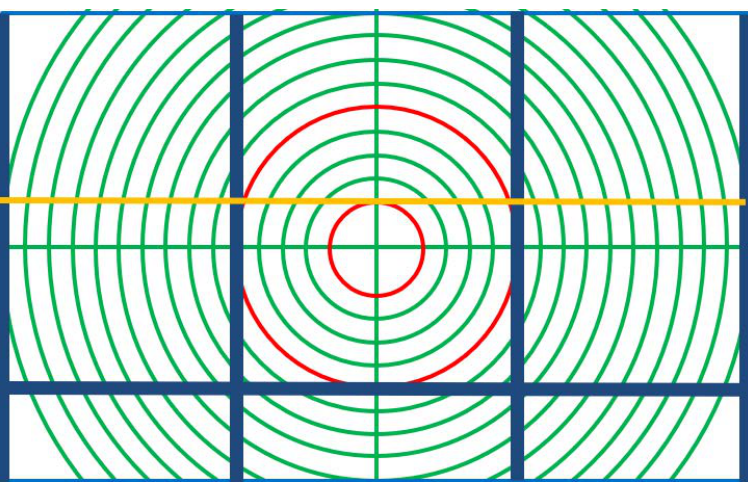
Figure 13. Diagonals removed, circles added, tripartite vertical division, and the dado. Source: the author.